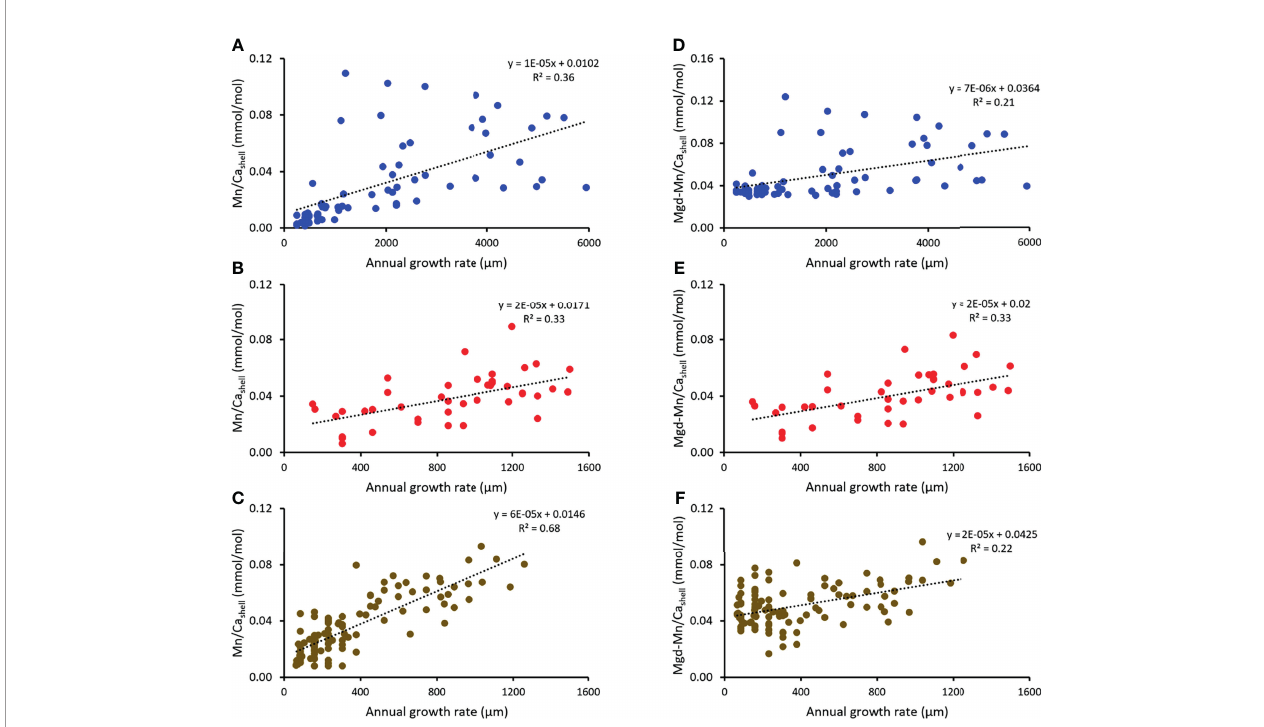
FIGURE 8 | Linear relationship between monthly Mn/Ca shell and annual growth rate before (A-C) and after detrending with Mg/Ca shell data (D-F) . (A, D) A. islandica , station FBR36; (B, E) A. elliptica , FBR36; (C, F) A. borealis , FBR06. All correlations were highly signi fi cant at p <